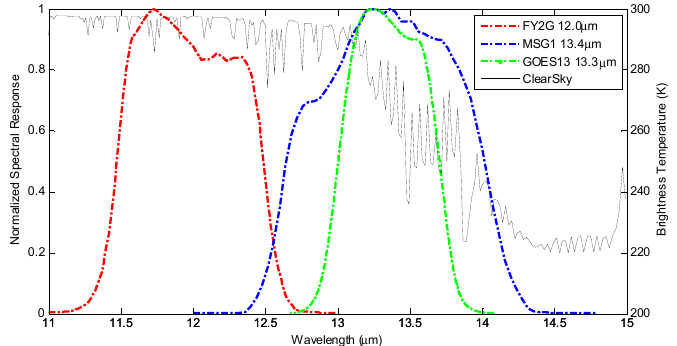
Figure 2. Typical spectral response functions, i.e., red for the FY-2G IR2 (12.0 μ m) band, blue for the MSG1 13.4 μ m band, green for the GOES-13 13.3 μ m band, and clear-sky spectral radiance MSG1 13.4 µ m band, green for the GOES-13 13.3 µ m band, and clear-sky spectral radiance (presented (presented as brightness temperature) for the U.S. Standard Atmosphere. as brightness temperature) for the U.S. Standard